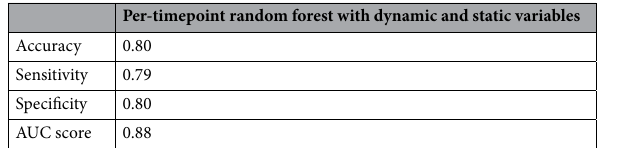
Logistic regression with static variables only